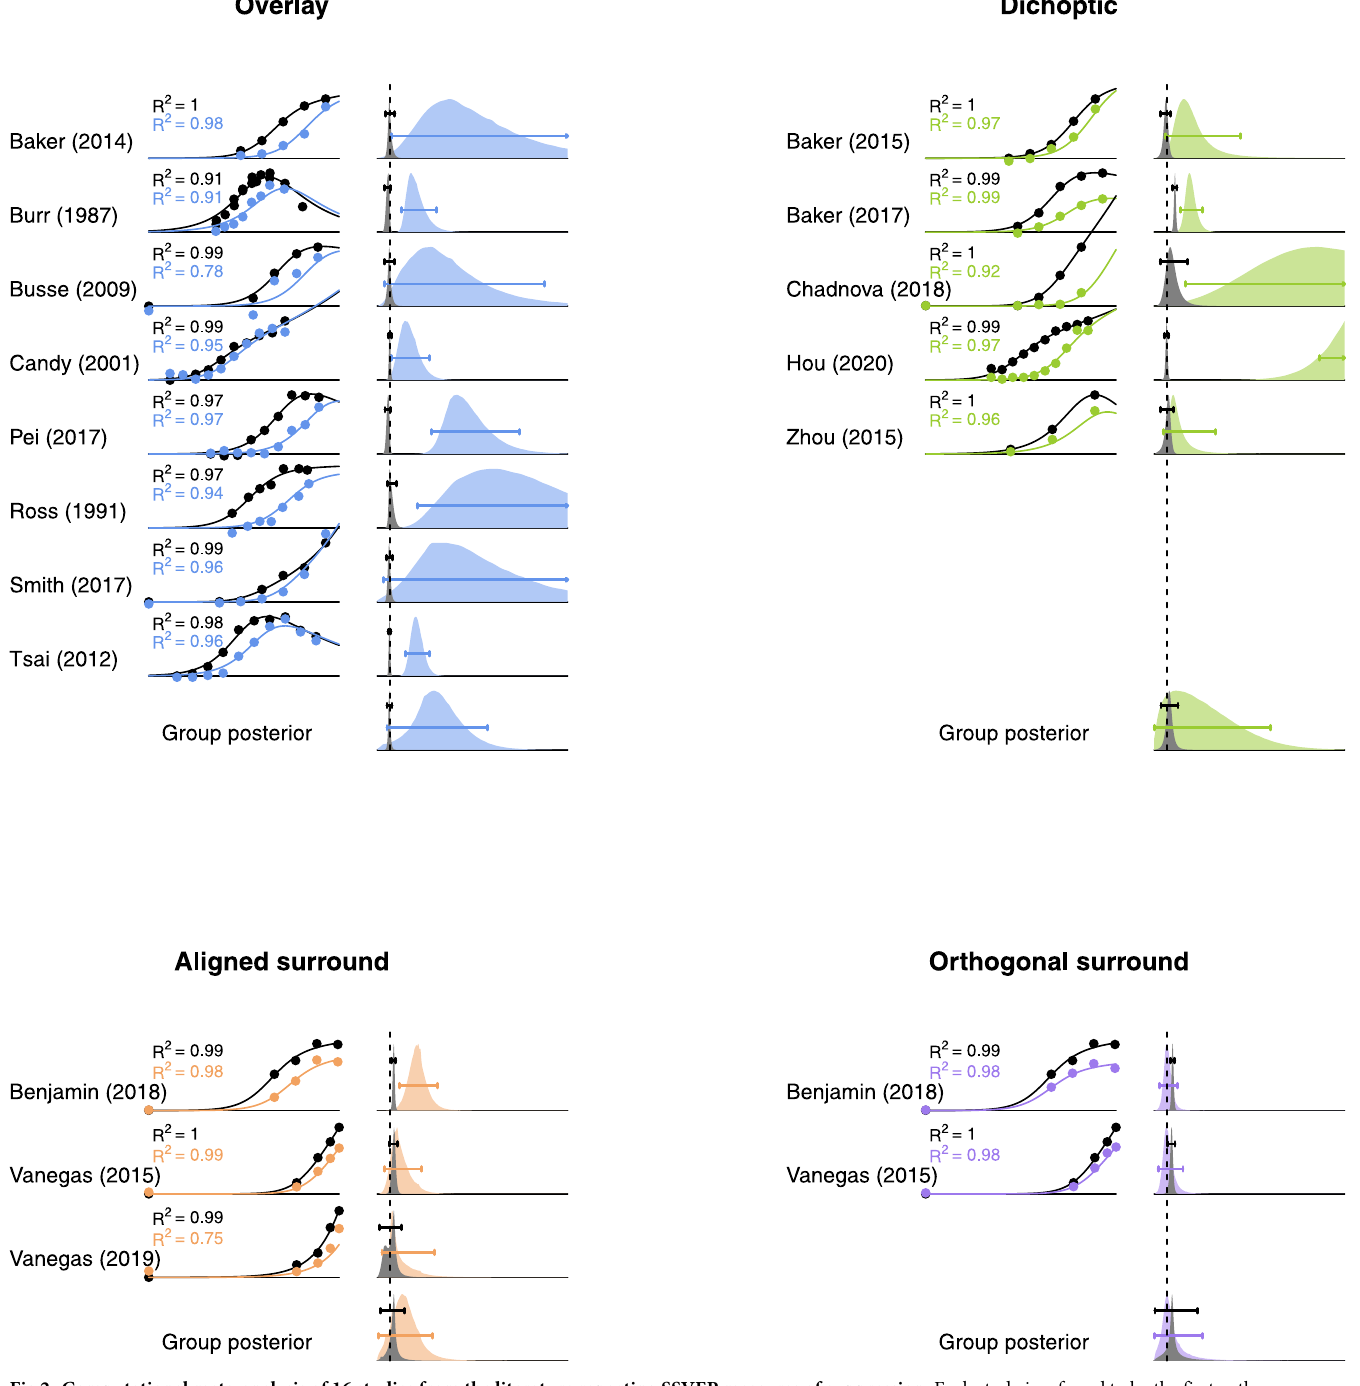
PLOS Computational Biology | https://doi.org/10.1371/journal.pcbi.1009507 October 13,